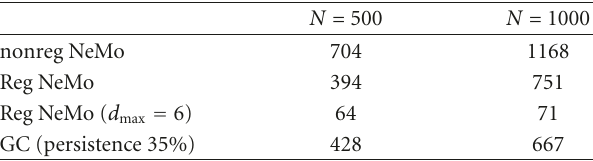
Table 2: Average packet overhead (in